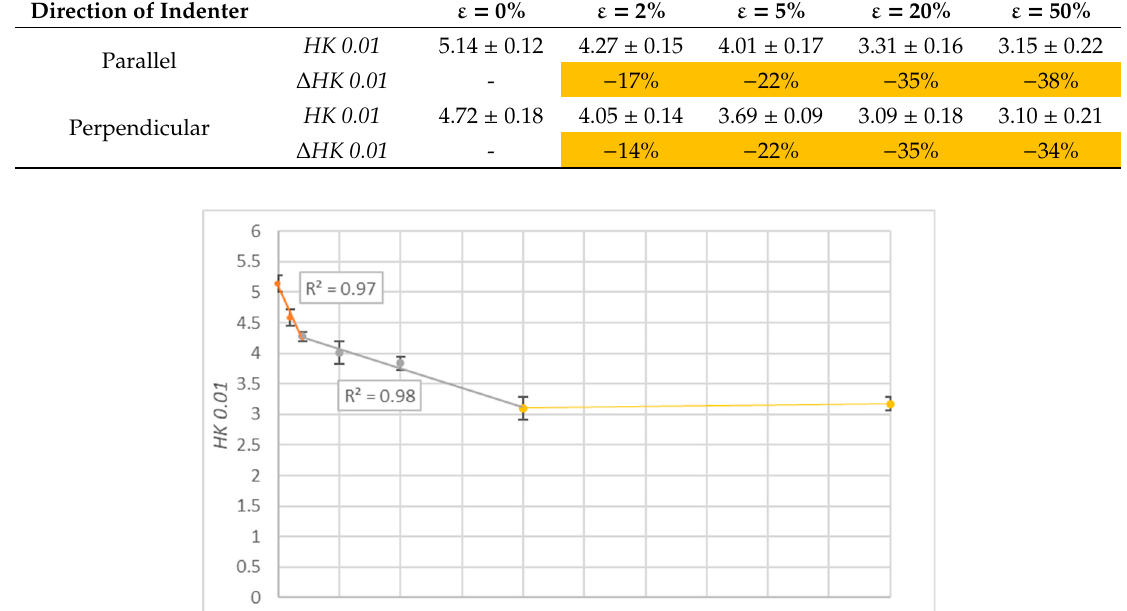
Table 5. Results of microhardness tests for polymers maintained in deformation for 24 h.